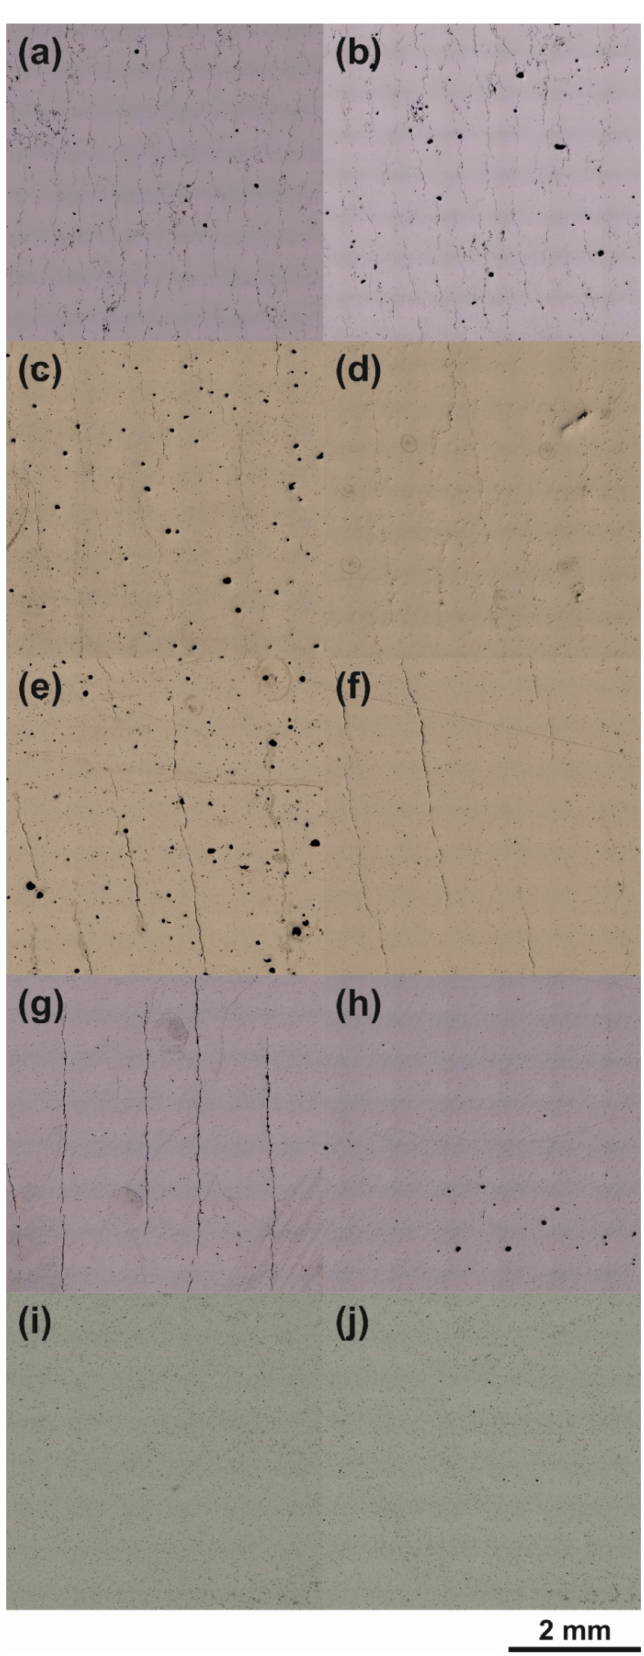
Figure 9. Micrographs of samples derived from the different powder variants, manufactured with the same parameters (one parameter set per column) via PBF-LB/M: ( a , b ) AA7075, ( c , d ) AA7075/TiC/0.5, ( e , f ) AA7075/TiC/1.0, ( g , h ) AA7075/TiC/1.75, ( i , j )